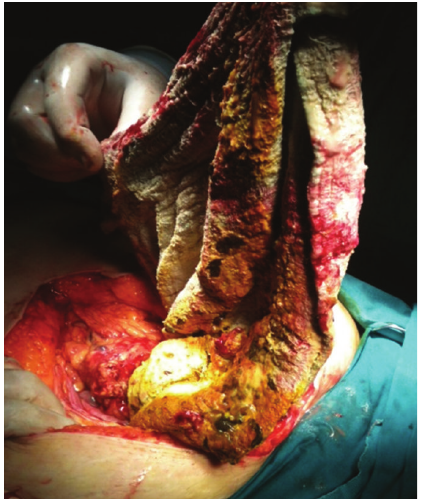
Figure 4: Surgical specimen